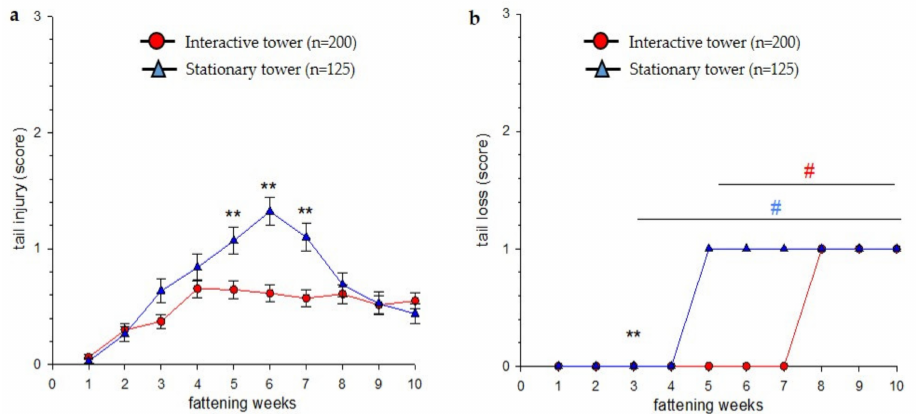
Figure 6. Scoring of tail injury and tail loss in the experimental and control group (number of pigs ( n ) indicated in the legend). ( a ) Tail injuries (score 0–3) of individual pigs in the different groups are presented as means ± SEM. In case more than nine pigs in a pen suffered from acute tail injuries, the respective pen was excluded from evaluation. ( b ) tail loss presented as median (score 0–3) of individual pigs. Statistics were performed using a non-parametric test. Significant differences are indicated: ** p < 0.01, Mann–Whitney U test, experimental versus control group. # p < 0.05, Dunn’s method indicated for all weeks significantly compared to week 1 (stationary tower in blue, interactive tower in